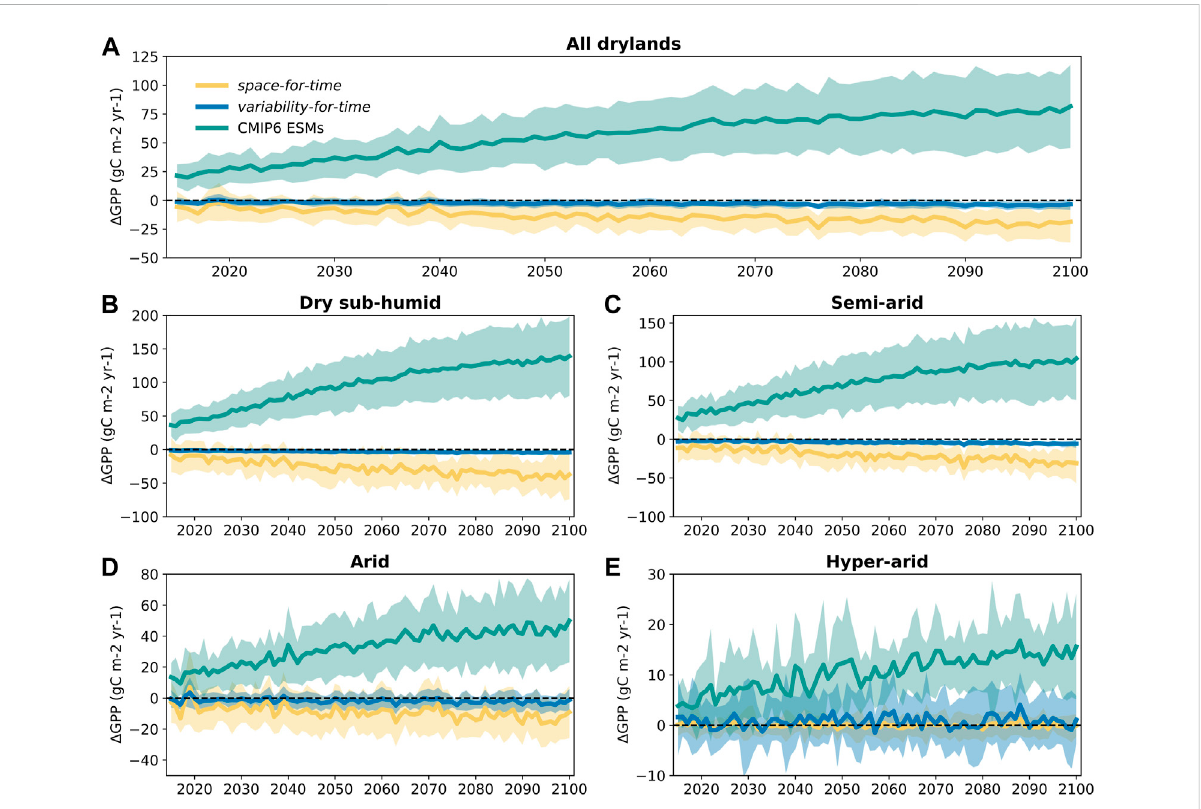
FIGURE 4 The future trajectory of GPP changes estimated by different approaches. The GPP changes ( Δ GPP) are aggregated over (A) all global drylands, (B) dry sub-humid, (C) semi-arid, (D) arid,and (E) hyper-aridregions. The Δ GPPiscalculated as thedifferencebetweenthefuturepredicted GPP and the baseline values averaged over 1958 – 2014. The solid lines denote the ensemble average across 18 CMIP6 ESMs and the shaded areas represent the ±1 standard deviation among